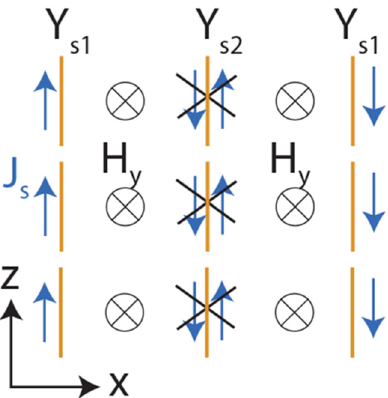
Figure 9: A cascade of three sheet admittances can realize independent electric and magnetic responses.